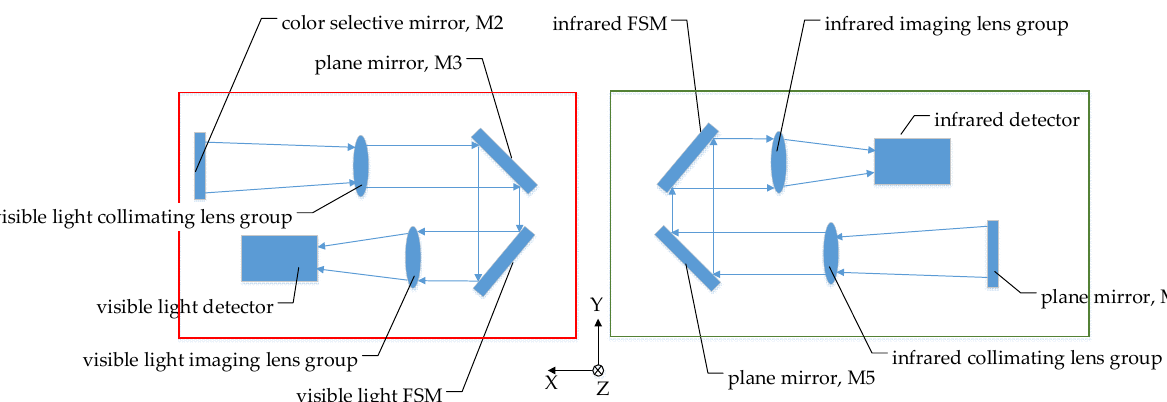
Figure 3. Visible light ( left )/infrared ( right ) subsystem.